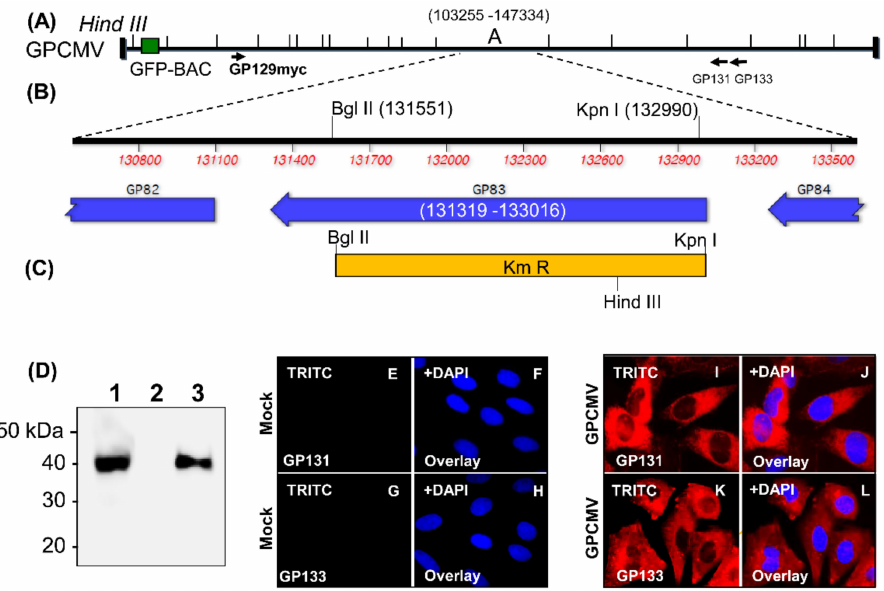
Figure 1. Generation of GP83 null PC+ GPCMV mutant virus (GP83dPC+). ( A ) Linear diagram of the GPCMV genome showing Hind III genomic map, location of excisable BAC plasmid (GFP-BAC), and ectopic GP129 (Gp129myc) in GP25-GP26 intergenic locus to enable PC expression. Location of additional unique PC components GP131 and GP133 also indicated. ( B ) GP83 locus encoded in Hind III ‘A’ GPCMV subgenomic fragment (nucleotides 103255–147334) and location of restriction enzyme sites Bgl II (131551) and Kpn I (132990) within GP83 coding sequence (131319–133016) used to delete majority of ORF via shuttle vector pGP83dKm and subsequently modify the GPCMV BAC via ET recombination to remove the majority of the GP83 coding sequence (codons 7–485) and substitute in place a kanamycin (Km) cassette ( C ). GP83 mutant virus (GP83dPC+) generated by transfection of GPCMV BAC DNA onto GPL fibroblast cells and excision of BAC plasmid. Virus infected cell expression of ectopic GP129 verified by Western blot ( D ) of GP83dPC+ infected cell lysate (lane 1), mock infected GPL (lane 2), and parental (GP83+) virus GP129FRT (lane 3) for myc epitope tagged GP129 protein as described in Materials and Methods. Expression of the additional unique components of the PC (GP131 and GP133) in GP83dPC+ infected GPL cells was verified by immunofluorescence assay with custom antibodies to GP131 ( I , J ) and GP133 ( K , L ). Primary antibodies: mouse anti-GP131 or anti-GP133 (Genscript); and secondary: anti-mouse IgG- TRITC conjugate (Sigma). Control immunofluorescence assays on mock infected cells for GP131: ( E , F ); and GP133: ( G , H ). Counterstain DAPI and TRITC overlay for mock and virus infected cells: ( F , H , J , L ). Images at 20 ×